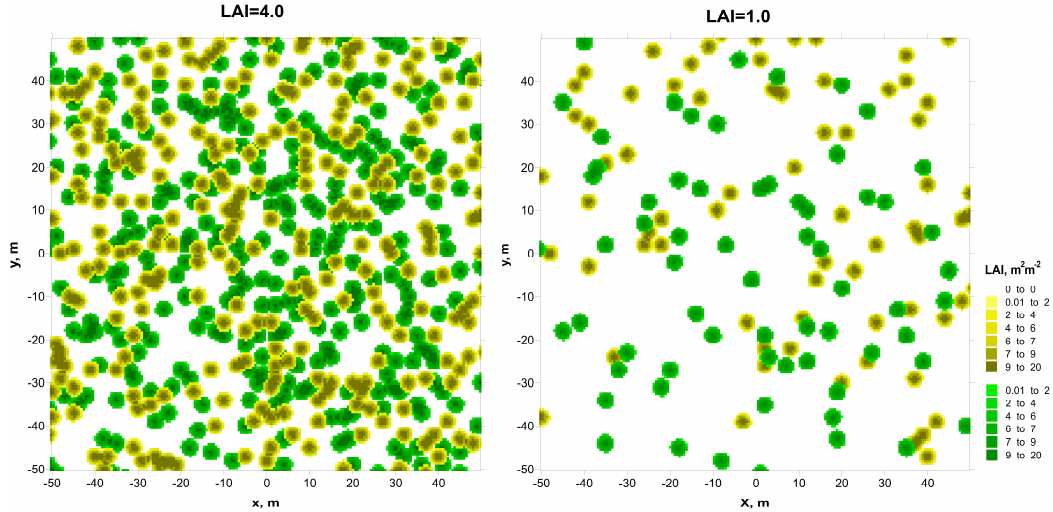
Figure 2. The spatial distributions of birch and pine leaf area index (LAI) within the modeling domain for a scenario, assuming the same proportion of both tree species within the forest stand. Birch and pine trees are shown by green and yellow colors, respectively.